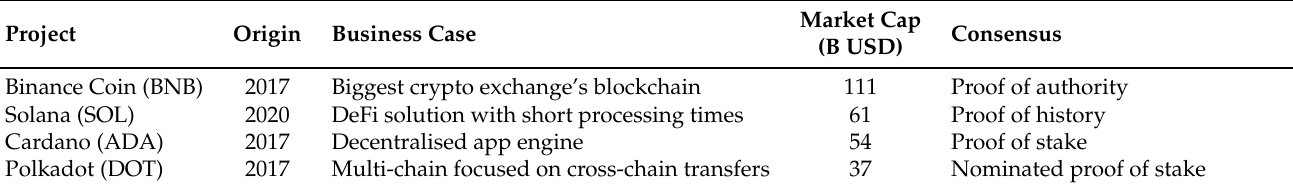
Table 8. Public blockchain projects within the